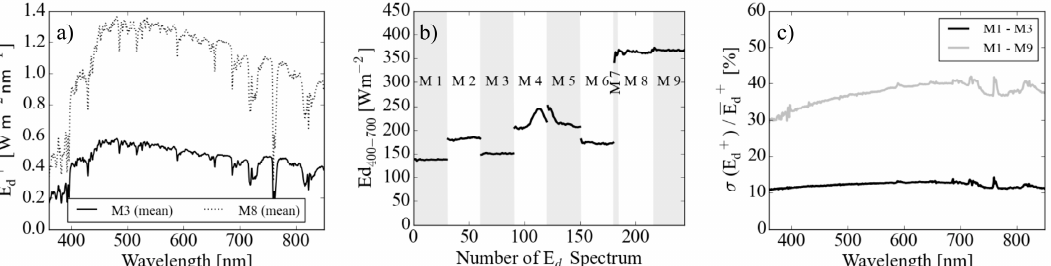
Figure 4. ( a ) Comparison of average E + ( λ ) spectra for different shares of clouds (M3: sun behind clouds, M8: sun visible). ( b ) Changes in the magnitude of irradiance (integrated over 400 to 700 nm) illustrating the variability in the illumination conditions. ( c ) standard deviation of E + ( λ ) normalized to average E + ( λ ) for “cloudy” measurements M1–M3 (black line) and all sets of measurements (grey line).